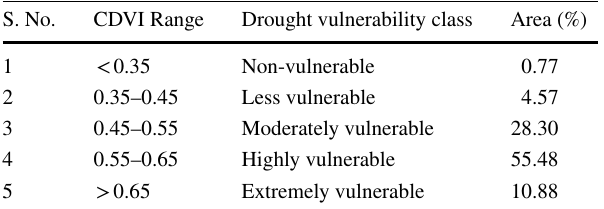
Fig. 11 Spatial distribution of CDVI over Narmada River Basin Table 4 Classification of CDVI into different drought vulnerability